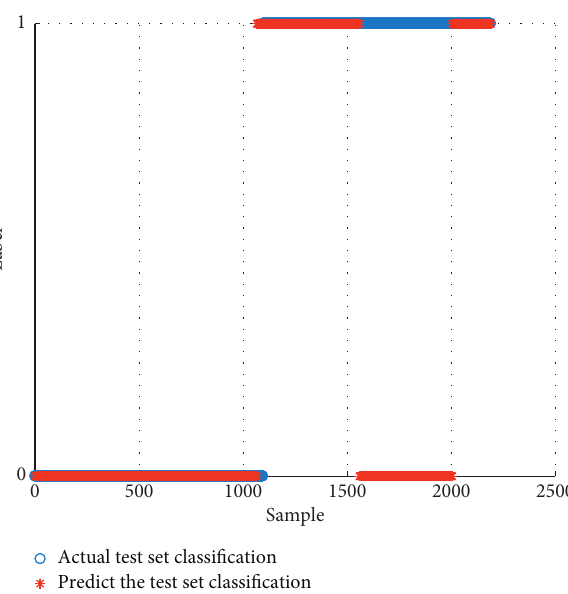
Figure 12: Mechanical failure comprehensive simulation experiment bearing outer ring failure results based on